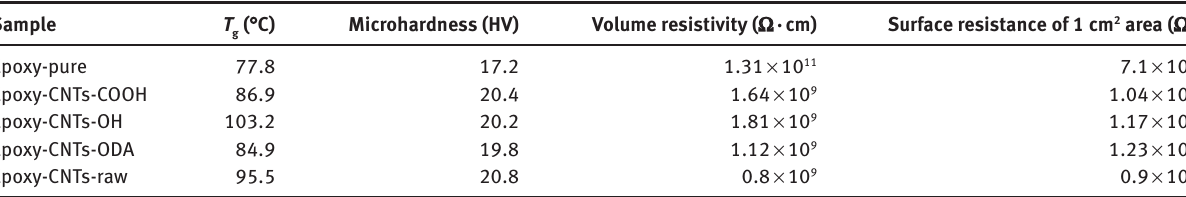
Table 1: Different properties of pure epoxy and epoxy nanocomposites.